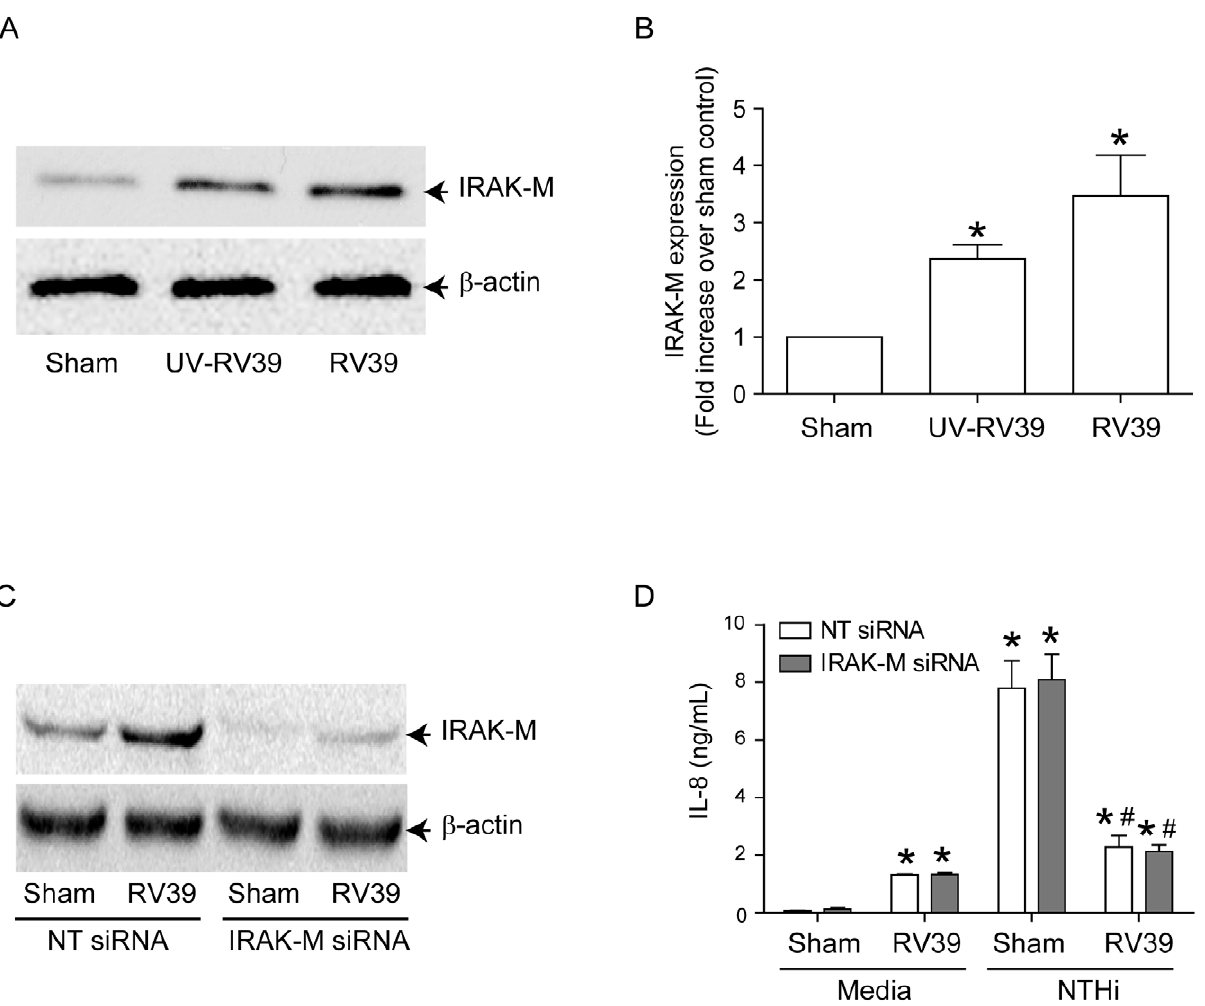
Figure 5. IRAK-M is not responsible for RV-induced suppression of NTHi-stimulated IL-8 in airway epithelial cells. (A and B) BEAS-2B cells were infected with sham, RV39 or UV-RV39 as described under Figure 2. Aliquots of total cell lysates corresponding to equal amount of protein from were subjected to Western blot analysis with IRAK-M antibody. (A) Representative blot showing IRAK-M expression. (B) Band intensities were quantified by NIH image and levels of IRAK-M was normalized to b -actin and expressed as fold increase over sham infected cells. (C) BEAS-2B cells were transfected with non-targeting (NT)- or IRAK-M siRNA and knockdown of IRAK-M was confirmed by Western blot analysis. (D) Similarly transfected cells were infected with sham or RV followed by NTHi as described in Figure 3 and IL-8 determined in the media. Data represents mean 6 SEM calculated from 3 independent experiments performed in triplicate (* p # 0.05, ANOVA, different from sham; # p # 0.05, ANOVA, different from